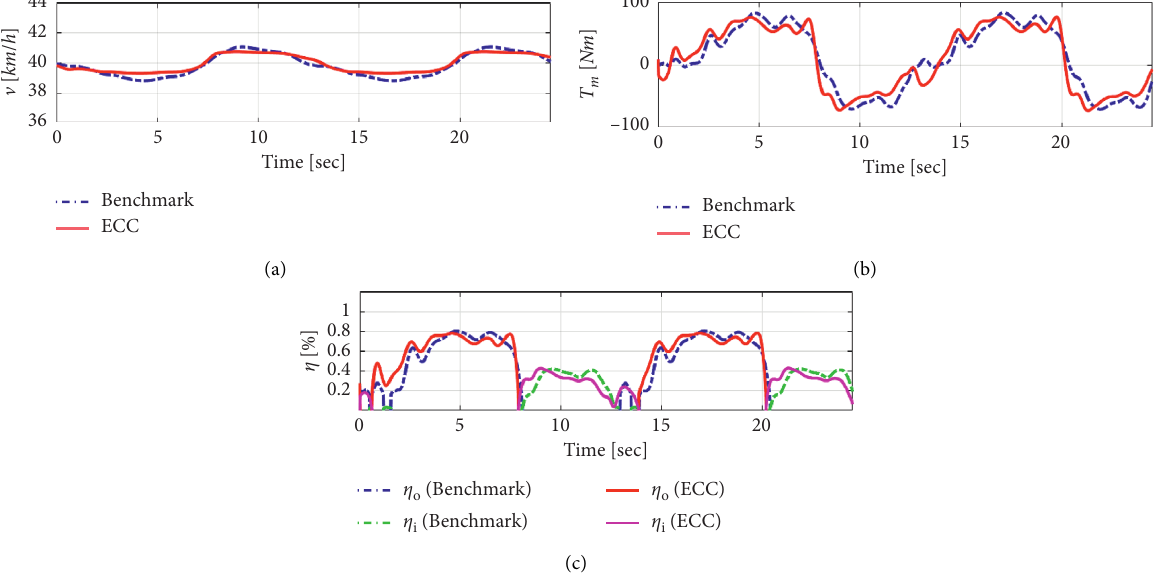
Figure 10: Control performances and comparison of ECC and benchmarked cruise control. (a) Vehicle speed. (b) Motor’s torque. (c) Motor’s